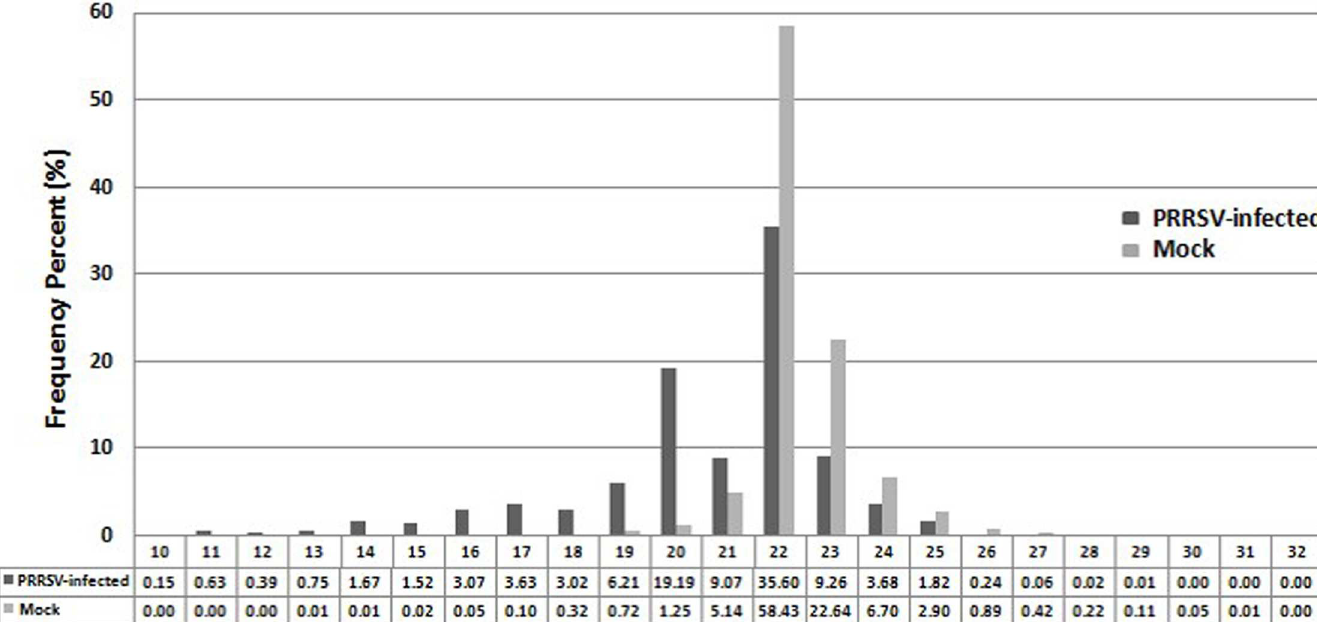
Fig 1. Length distributions of sRNAs (10–32 nucleotides) in PRRSV-infected and uninfected MARC-145 cells. s RNA libraries from PRRSV-infected MARC-145 cells in vitro were analyzed using Illumina deep sequencing. Within each sample, 86.03% and 95.2% high-quality sRNAs were ~18 to 24 nucleotides in length, with most sRNAs 22 nucleotides in